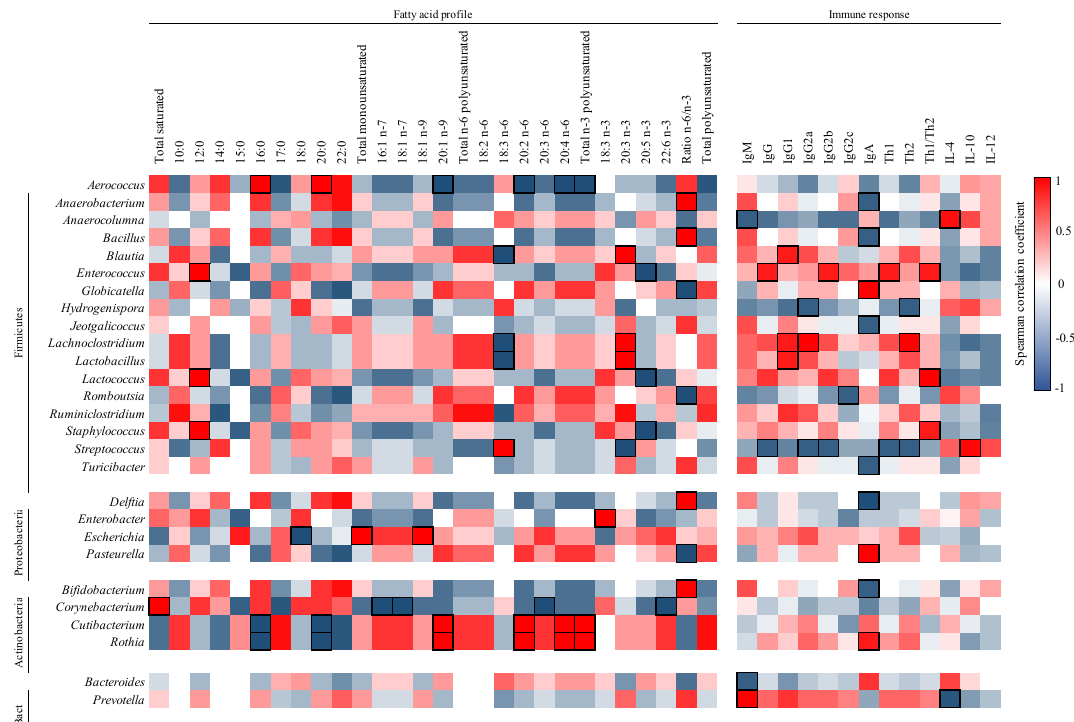
Figure 6. Correlation between the milk microbiota composition and the content of FA and Ig present in milk. The Spearman correlation coefficient is represented in the heat map following the color in the legend. Correlations with statistical significance ( p < 0.05) are shown in a bold frame. Results derived from n = 5.